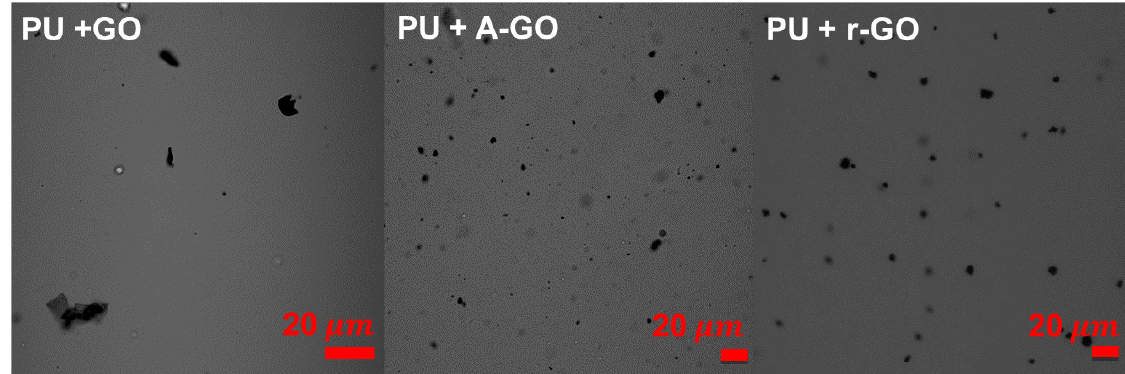
Figure 15. Confocal laser micrographs of the PUs with GO derivatives.